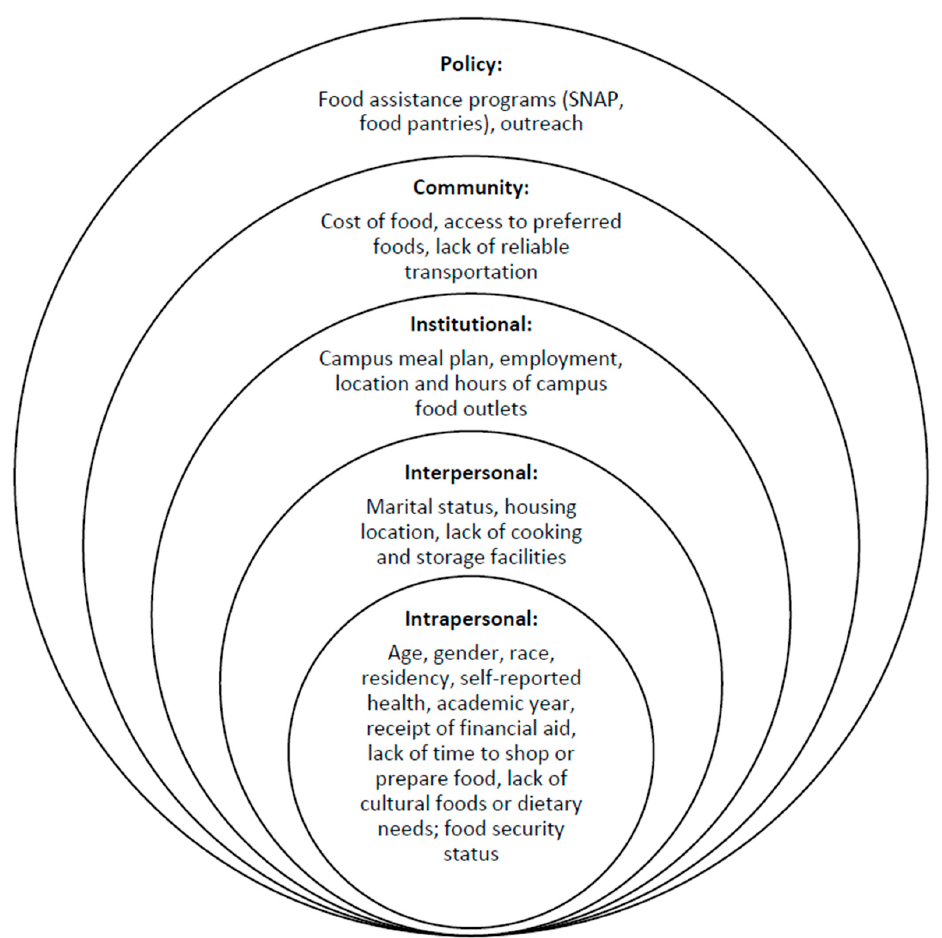
Figure 1. Socioecological model (SEM) levels of influence likely to affect college food insecurity.